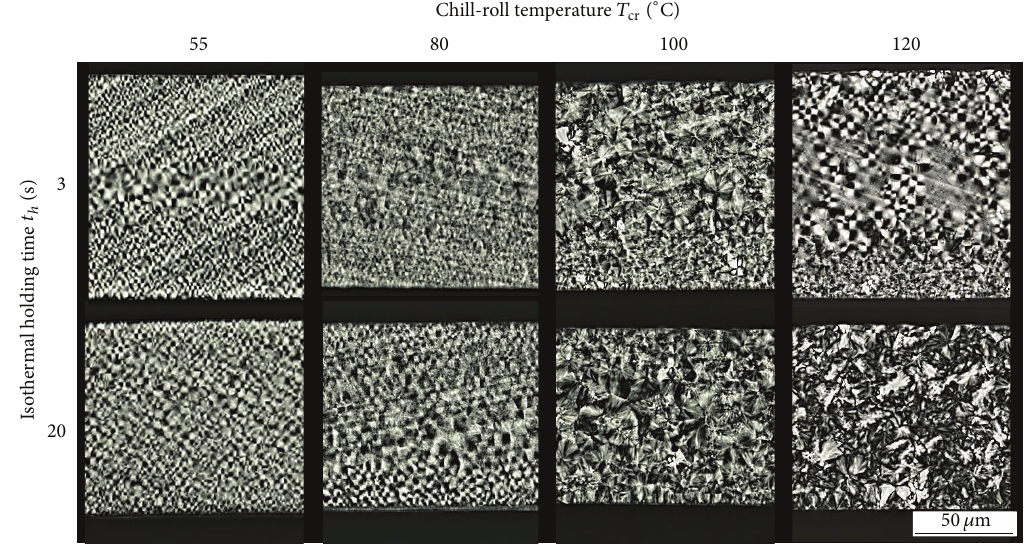
Figure 10: Morphology over the cross-section of extruded foils manufactured at different chill-roll temperatures and isothermal holding